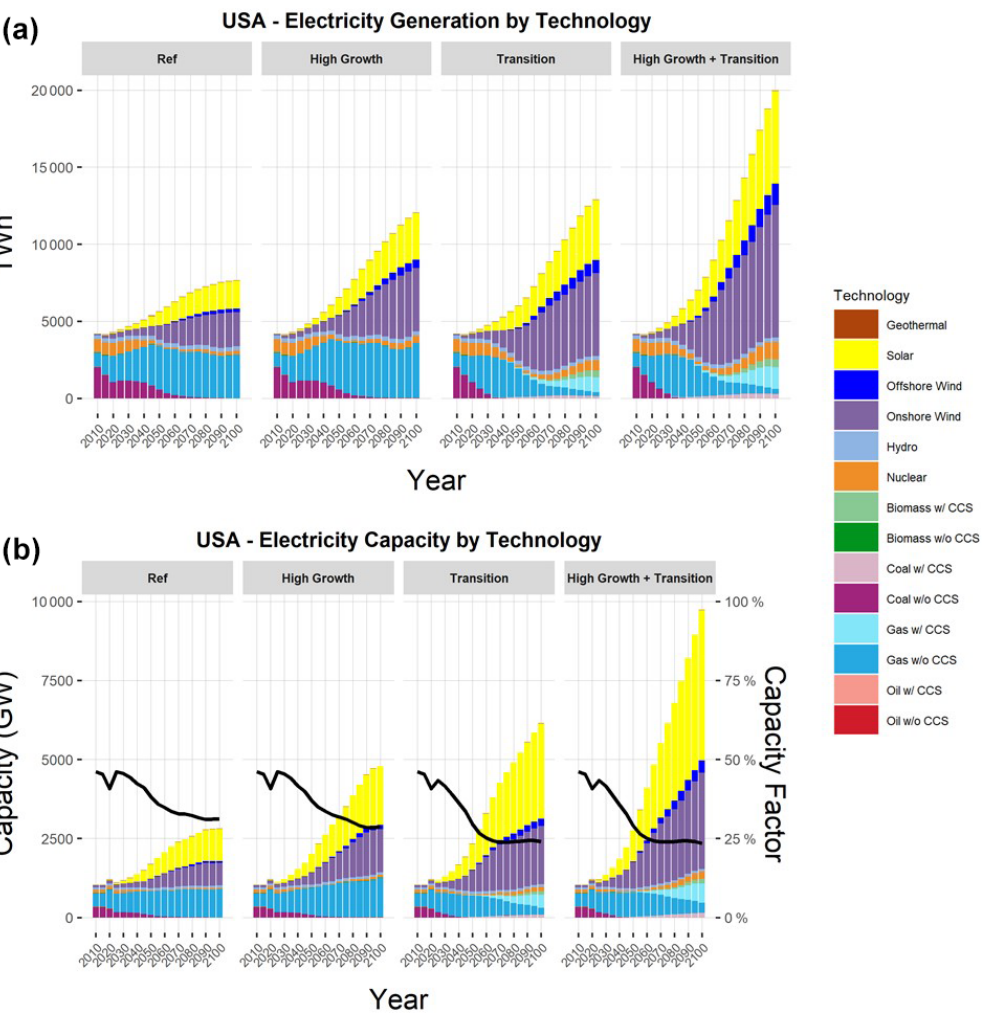
Figure 5. USA electricity generation (a) and capacity (b) by technology and scenario. Lines on capacity plots (b) represent national fleet average annual capacity factor and correspond to the secondary (right) y